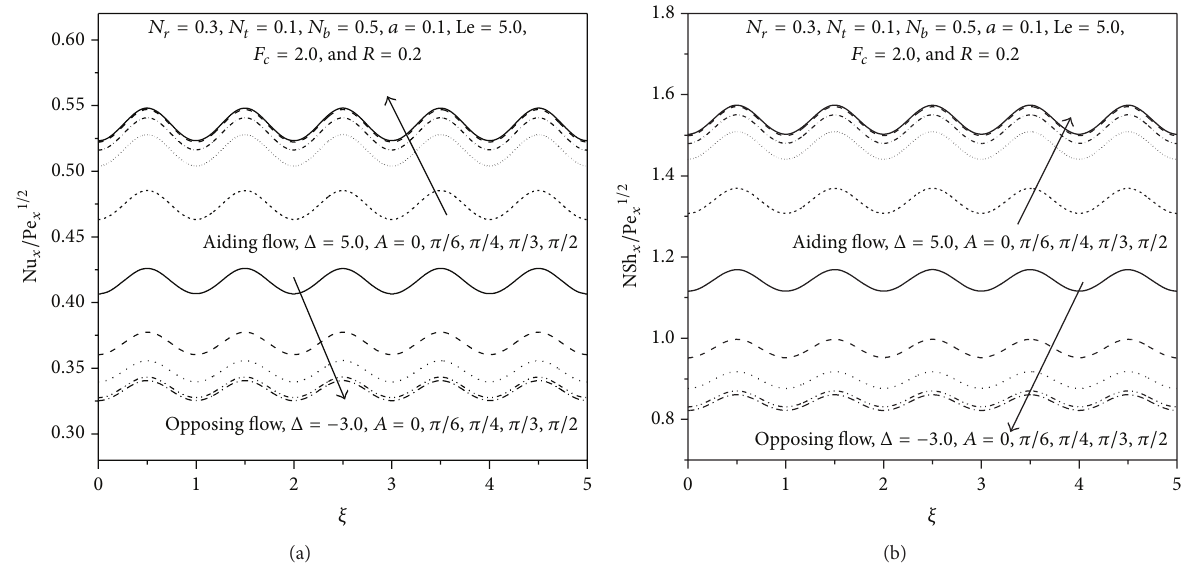
Figure 7: Effect of the angle of inclination ( 𝐴 ) on the heat and nanoparticle mass transfer